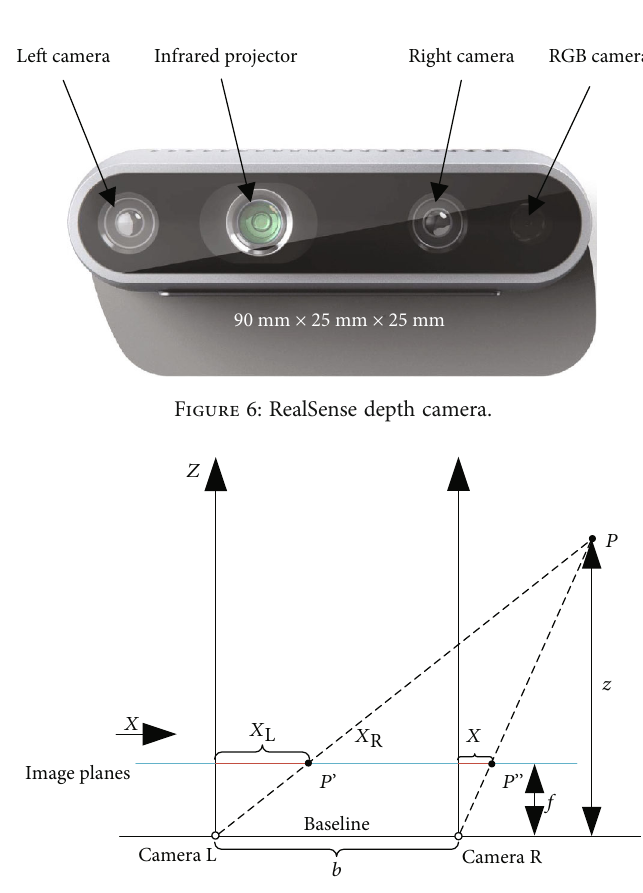
Figure 7: Principle of binocular stereo vision ranging.